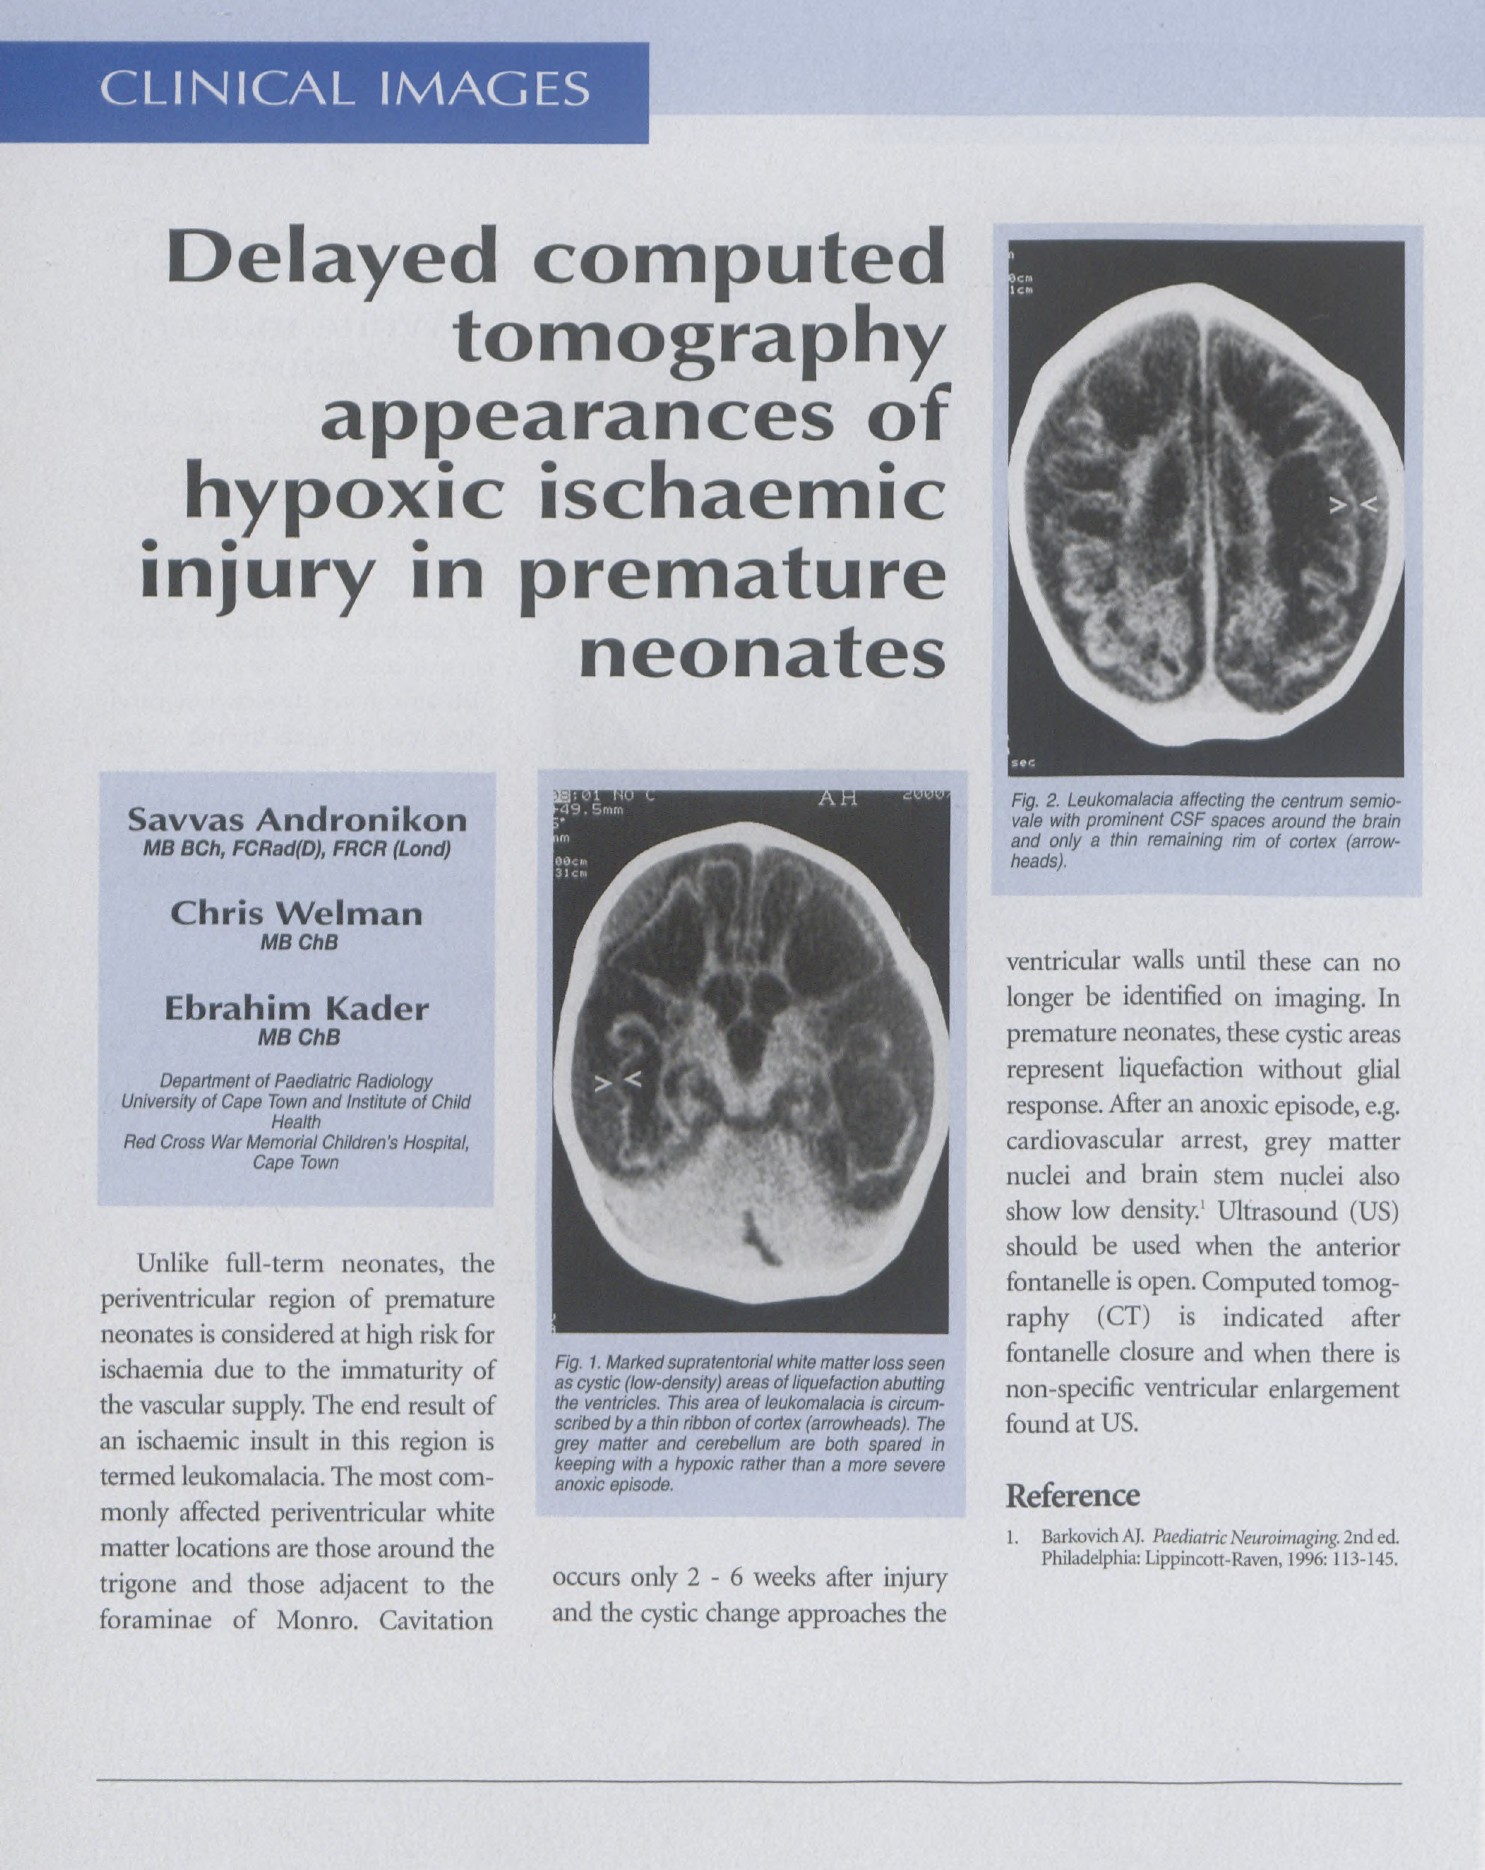
Fig. 1. Marked supratentorial white matter loss seen as cystic (low-density) areas of liquefaction abutting the ventncles. This area of leukomalacia is circum- scribed by a thin ribbon of cortex (arrowheads). The grey matter and cerebellum are both spared in keeping with a hypoxic rather than a more severe anoxic episode.